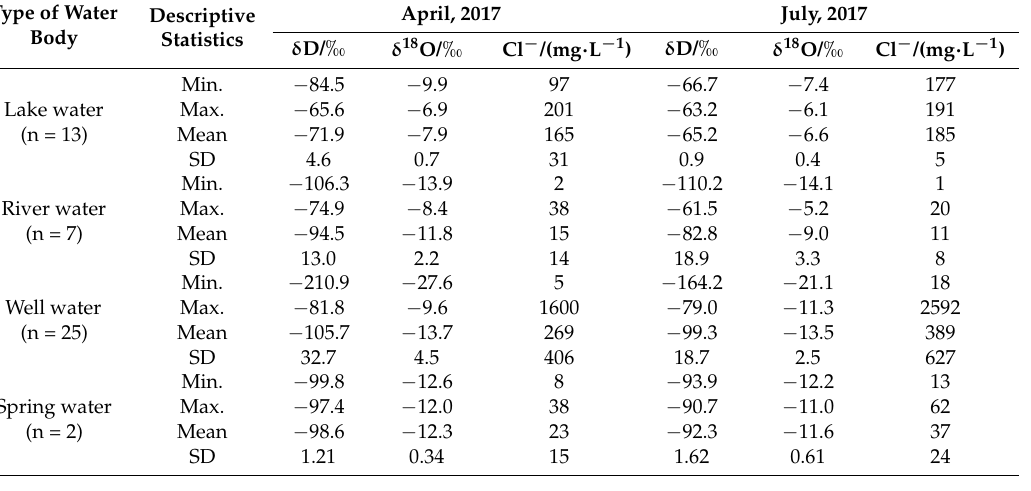
Table 1. Levels of hydrogen and oxygen isotopes and the results of the hydrochemical analysis of the water in the Lake Hulun Basin during the frozen and non-frozen study periods.